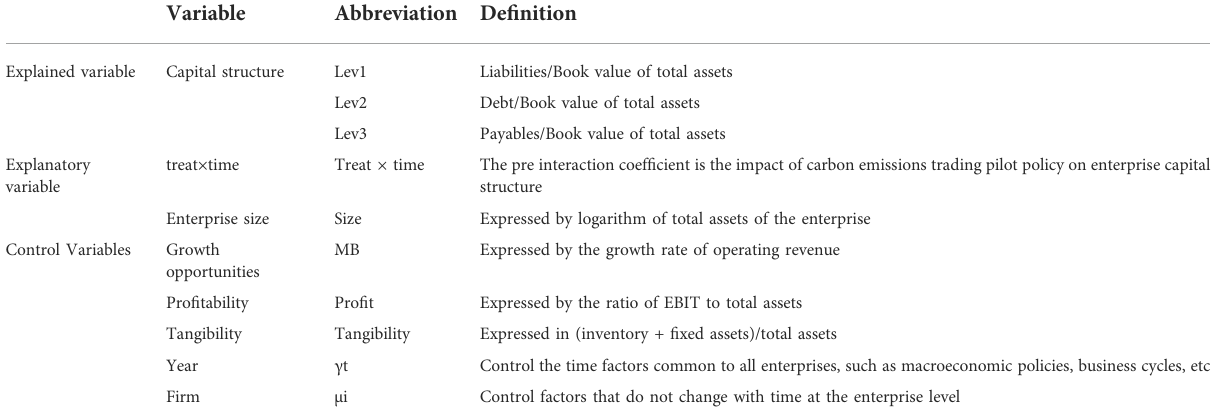
TABLE 3 The de fi nition of the